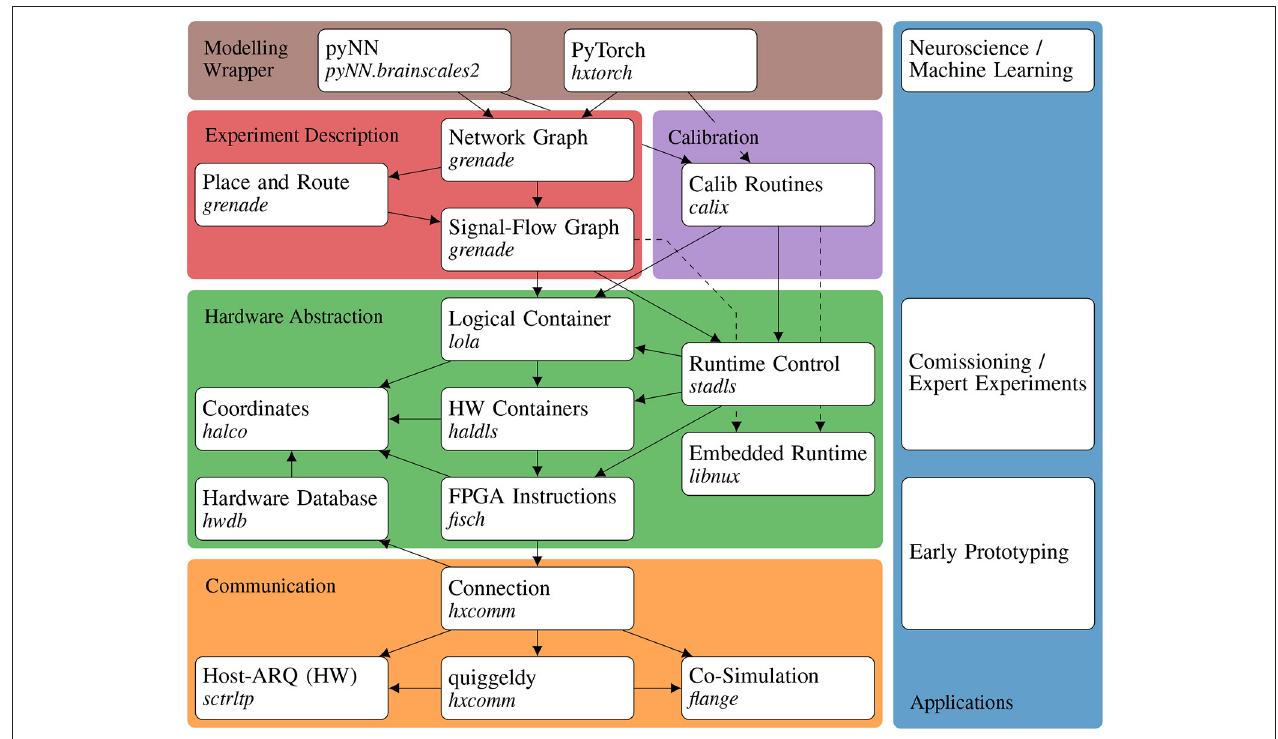
FIGURE 3 | Overview of the BSS-2 software architecture and its applications. Left side: Colored boxes in the background represent the separation of the software into different concerns. White boxes represent individual software APIs or libraries with their specific repositories names and dependencies. Right side: Various applications concerning different system aspects. The arrows represent dependencies in the stack, where the dependent points to its dependencies. For embedded operation additional dependencies on libnux are needed (dashed